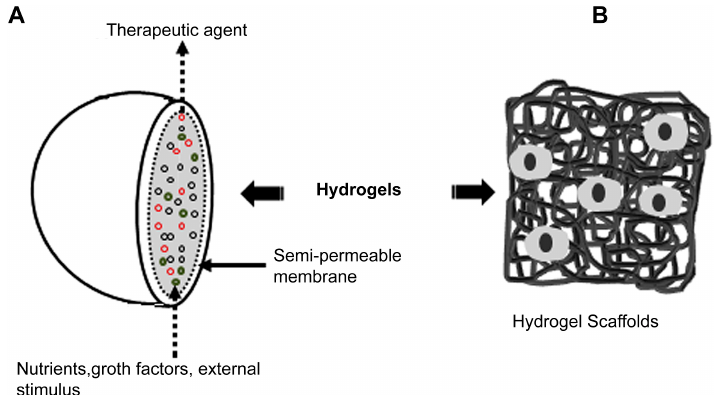
Figure 1. Hydrogels and tissue engineering. Schematic diagram of the use of hydrogels in ( A ) microencapsulation and ( B ) tissue-engineering scaffold. (Reprinted with permission from reference [16]. Copyright 2014 Elsevier).